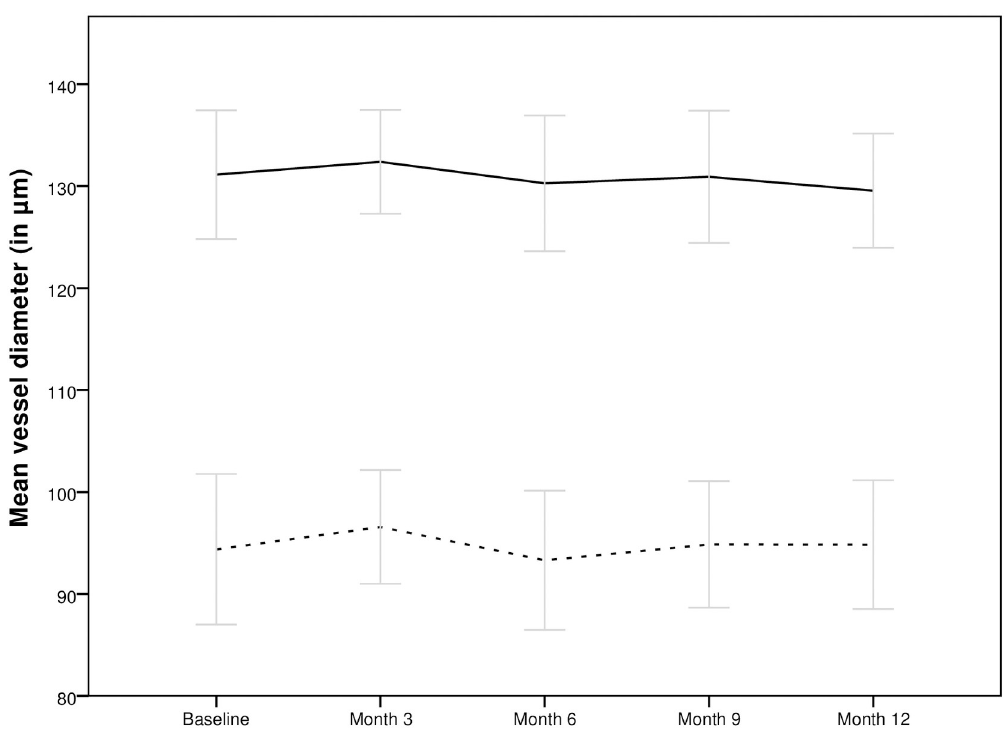
Fig 3. Course of arterial (dotted line) and venous (continuous line) vessel diameter of the total population during the treatment with aflibercept. No significant change was observed over the 12 months period.